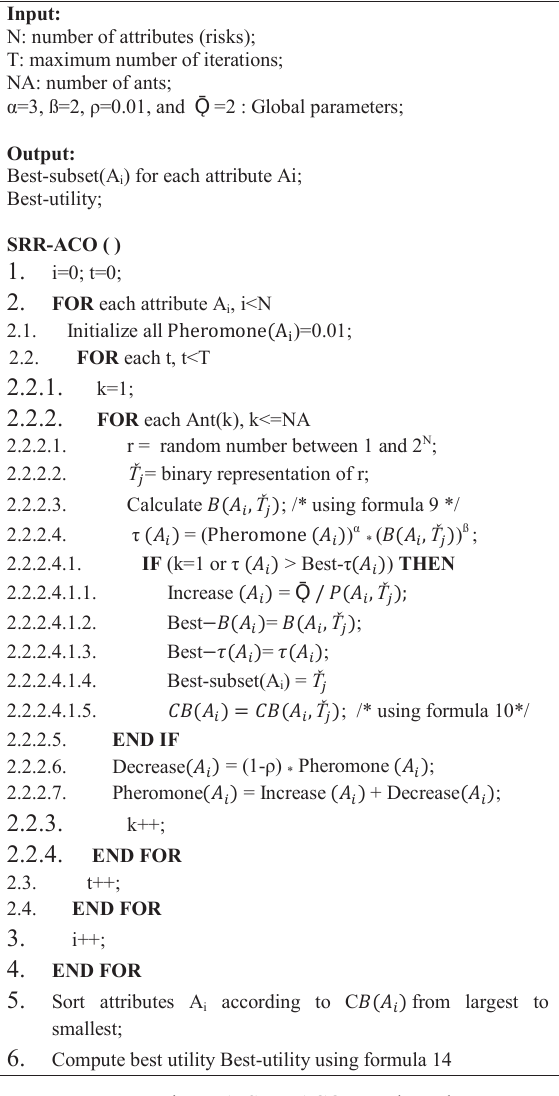
Figure 1: SRR-ACO pseudo